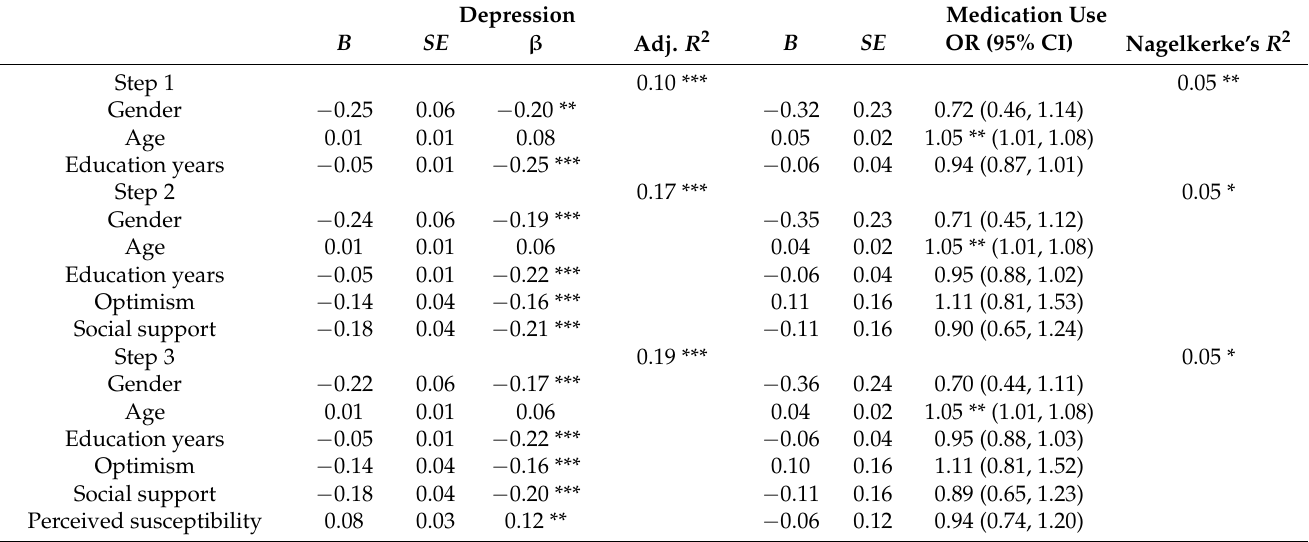
Table 3. Multiple hierarchical regressions for depression and medication use ( n =